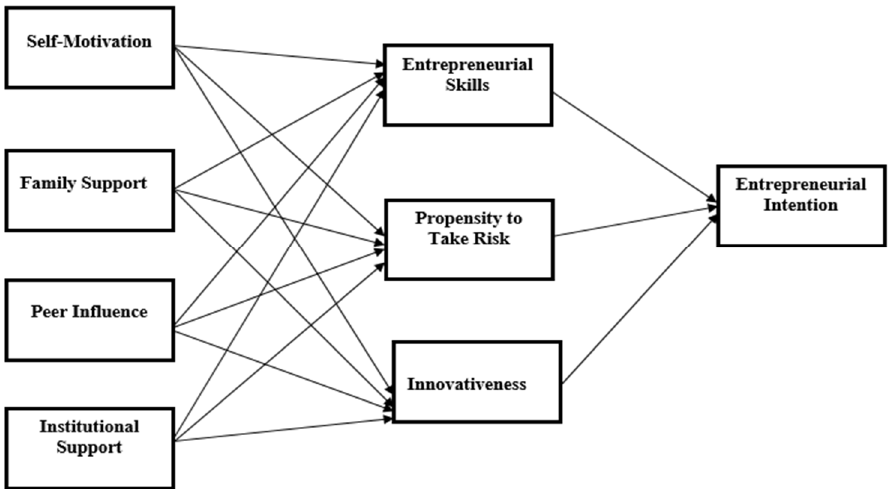
Figure 1. Conceptual model.